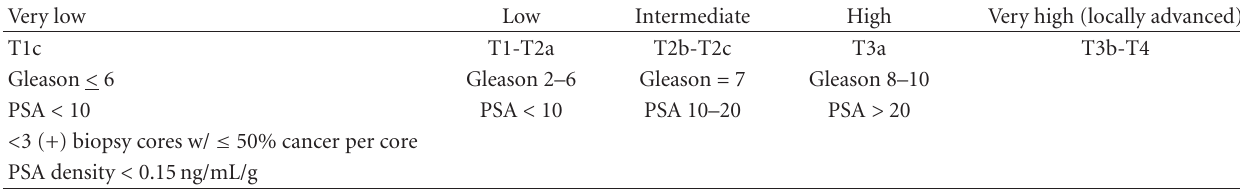
Table 2: Prognostic factors for recurrence risk in localized prostate